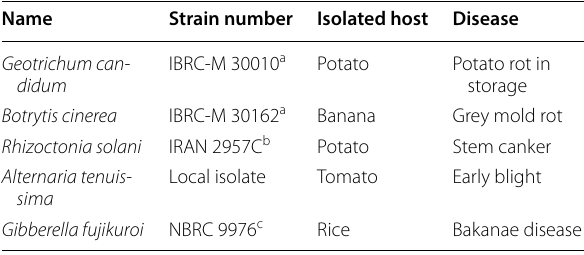
Table 1 Phytopathogenic fungi used in antifungal activity